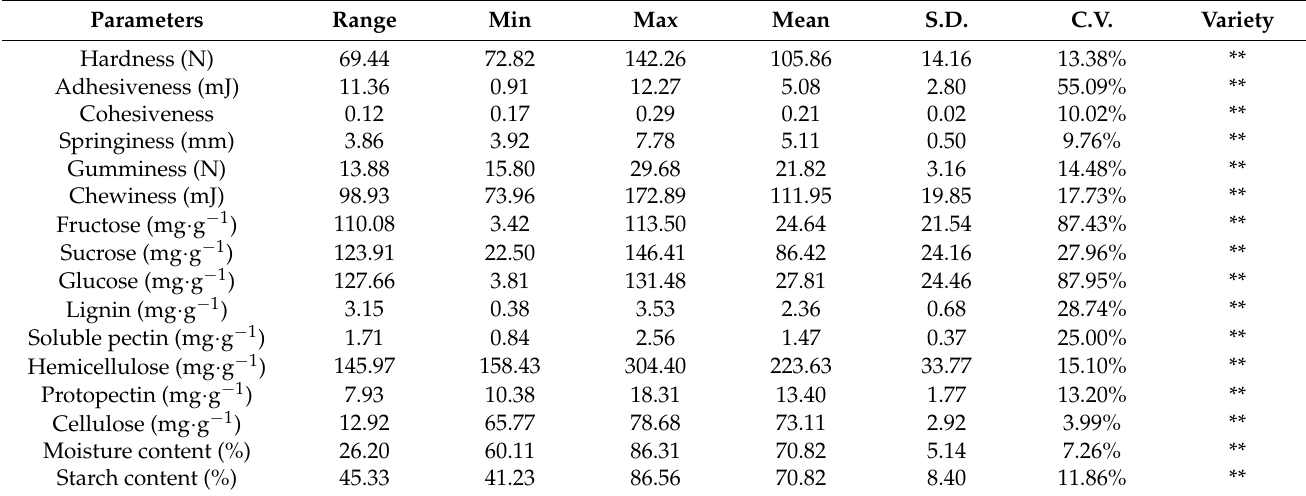
Table 2. Descriptive statistics of sweet potato tuberous root quality